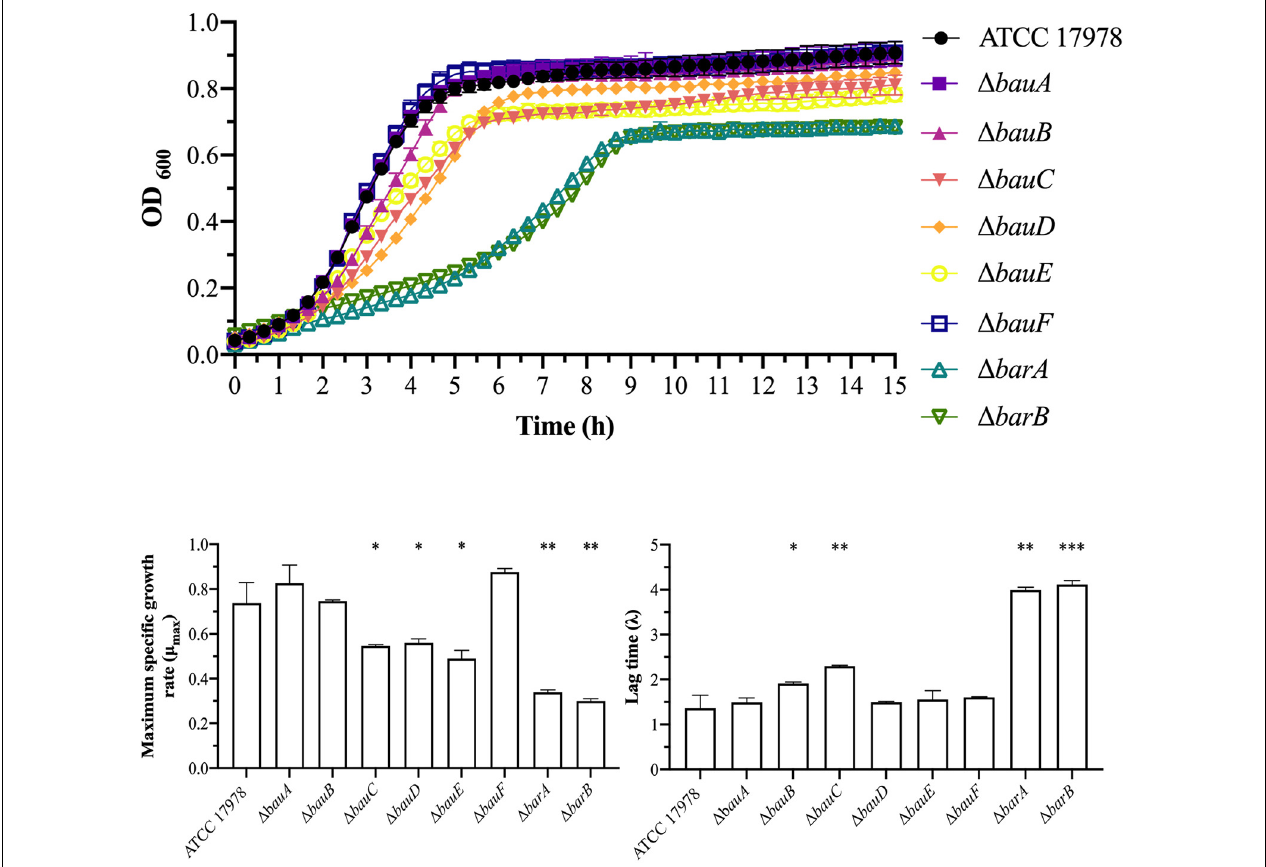
FIGURE 3 | Growth curves and growth kinetics of A. baumannii ATCC 17978 and the isogenic mutant derivative strains lacking genes involved in the transport of acinetobactin. The growth curves were performed under iron-limiting conditions. Three independent biological replicates were performed. Unpaired student t test was used for the statistical analysis of the growth kinetics ( ∗ P < 0.05; ∗∗ P < 0.01; ∗∗∗ P <